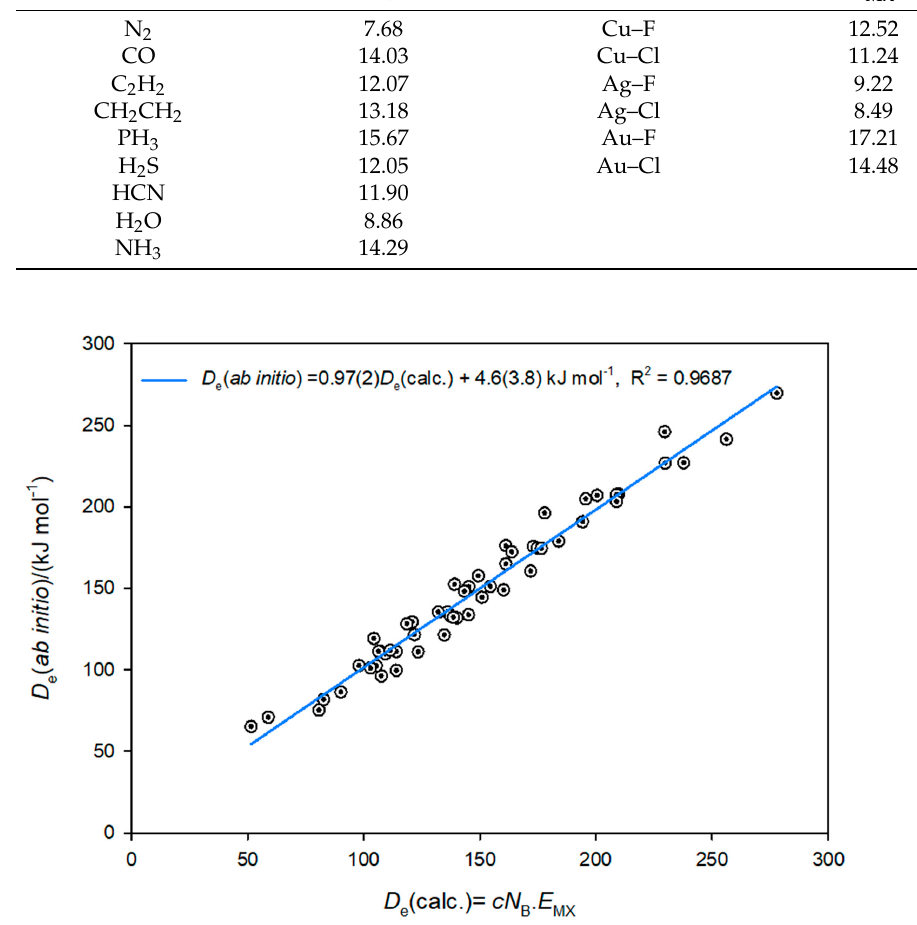
Figure 2. D e as calculated ab initio versus the values calculated from the nucleophilicity N B and electrophilicities E MX by Equation (2), D e = cN B · E MX